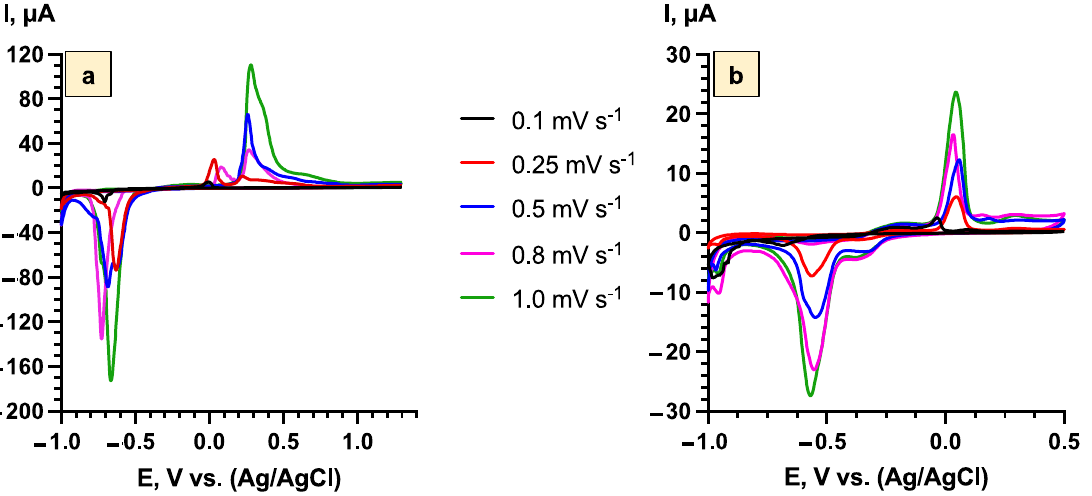
Figure 6. Cyclic voltammetry curves of Bi 2 Se 3 thin films in 5 M LiNO 3 in the scan rate range from 0.1 to 1.0 mV s − 1 after surface pre-treatment for: ( a )—SEI layer after third cycle ( − 1.0 V ÷ 1.3 V vs. Ag/AgCl), ( b )—Bi 2 O 3 layer after ninth cycle ( − 1.0 V ÷ 0.5 V vs.